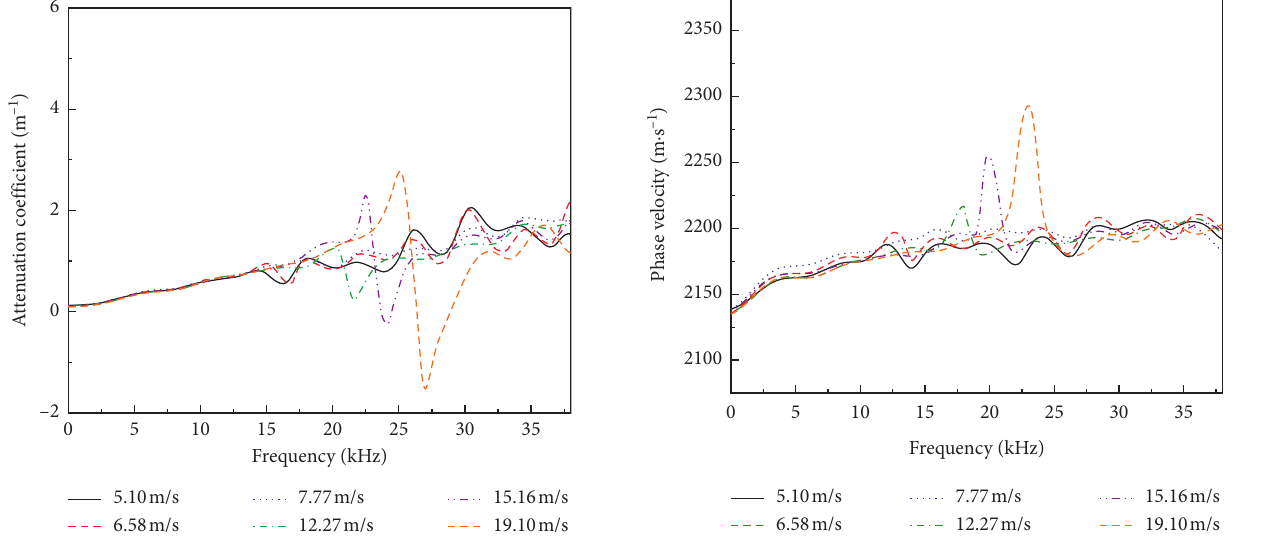
Figure 6: Relationship between attenuation coefficient and fre- quency at different impact velocities.